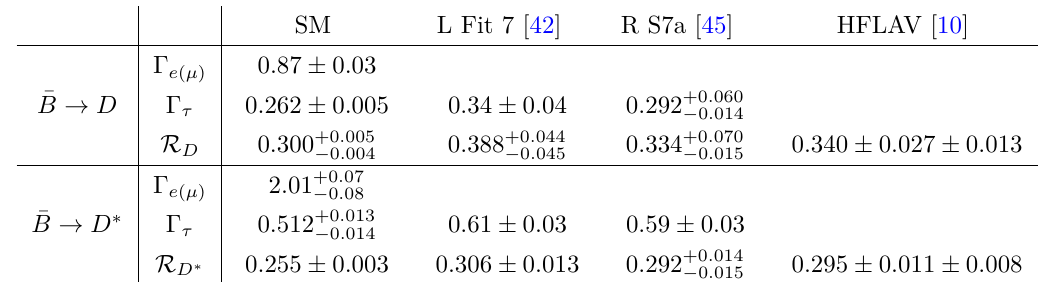
(cid:0) ¯ (cid:1) (cid:0) ¯ (cid:1) Table 3 . Semileptonic decay widths Γ τ = Γ B → D ( ∗ ) τ ¯ ν τ and Γ = Γ B → D ( ∗ ) e ( µ )¯ ν e ( µ ) e ( µ ) (cid:0) (cid:1) (cid:0) ¯ (cid:1) (cid:0) ¯ (cid:1) [units of 10 × | V cb | 2 ps − 1 ] and ratios R = Γ B → D ( ∗ ) τ ¯ ν τ / Γ B → D ( ∗ ) e ( µ )¯ ν obtained e ( µ ) D ( ∗ ) in the SM, the NP model Fit 7 (7a) of ref. [42] ([45]), which only includes left- (right-)handed neutrino NP operators. Errors induced by the uncertainties in the form-factors and Wilson Coef- ficients are added in quadrature. The R experimental averages compiled by the HFLAV [10] D ( ∗ ) collaboration are also